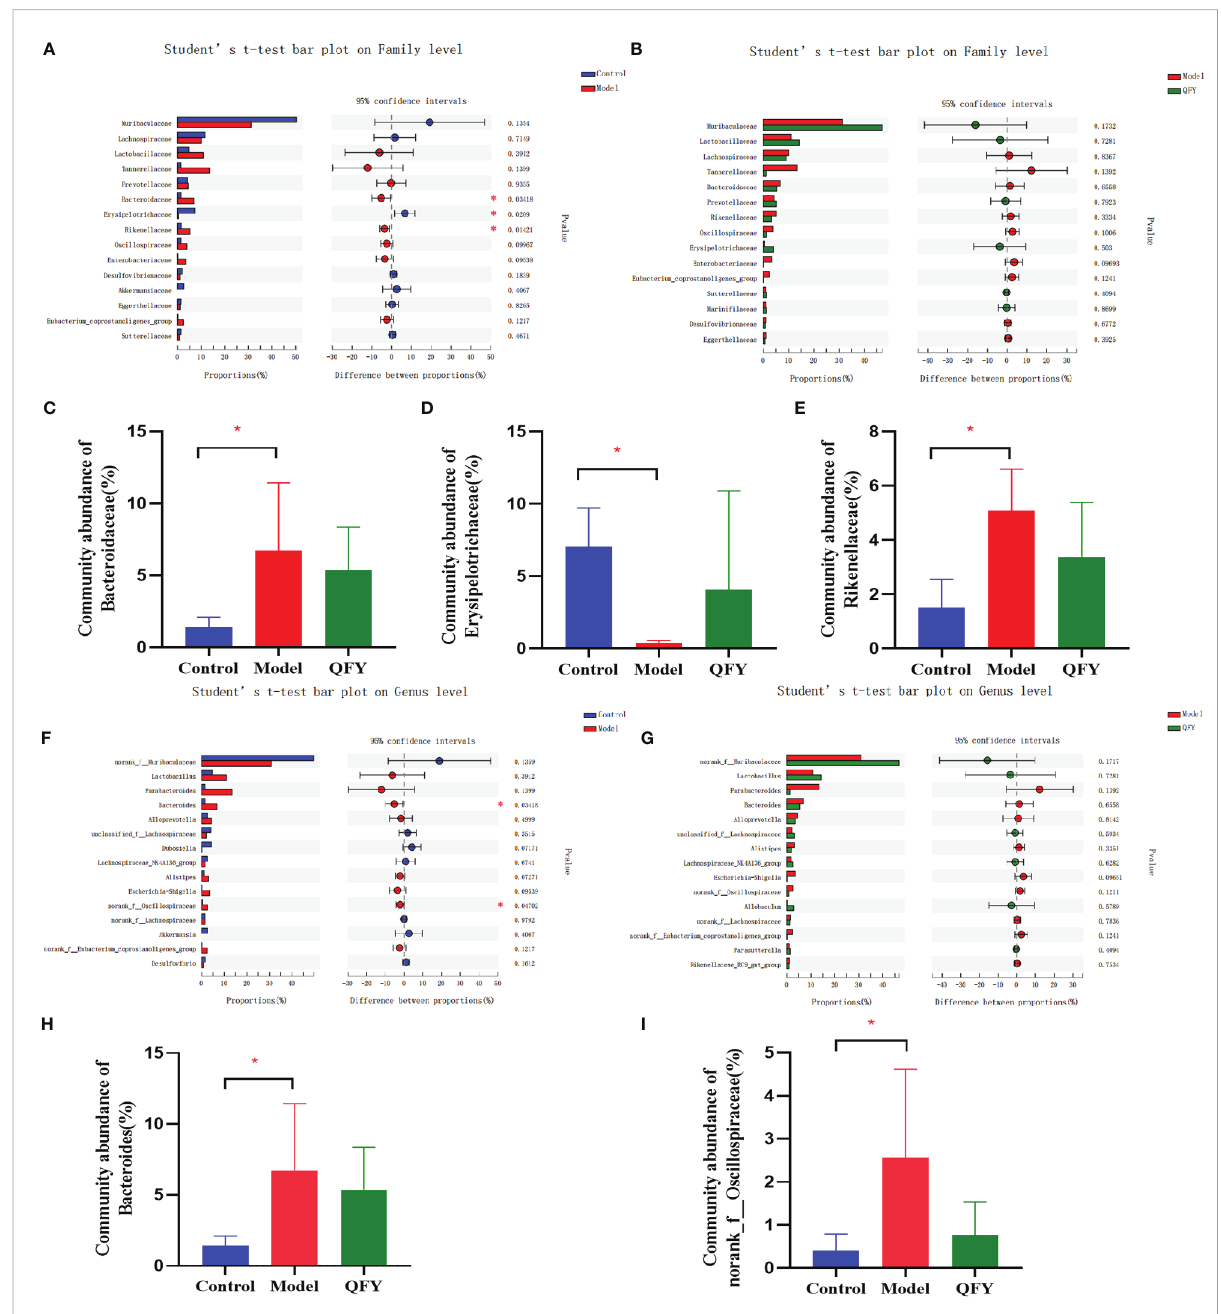
FIGURE 6 The effect of Qi-Fu-Yin on the relative species abundance of intestinal microorganisms in APP/PS1 transgenic mice. (A) Difference between control group and model group on family level, (B) Difference between model group and Qi-Fu-Yin group on family level, (C) Community abundance of Bacteroidaceae , (D) Community abundance of Rikenellaceae , (E) Community abundance of Erysipelotrichaceae , (F) Difference between control group and model group on genus level, (G) Difference between model group and Qi-Fu-Yin group on genus level, (H) Community abundance of Bacteroides , (I) Community abundance of norank_f:Oscillospiraceae. Mean ± SD, n=2~5, * P <0.05, unpaired Student ’ s- t test. GraphPad Prism 8.0.1